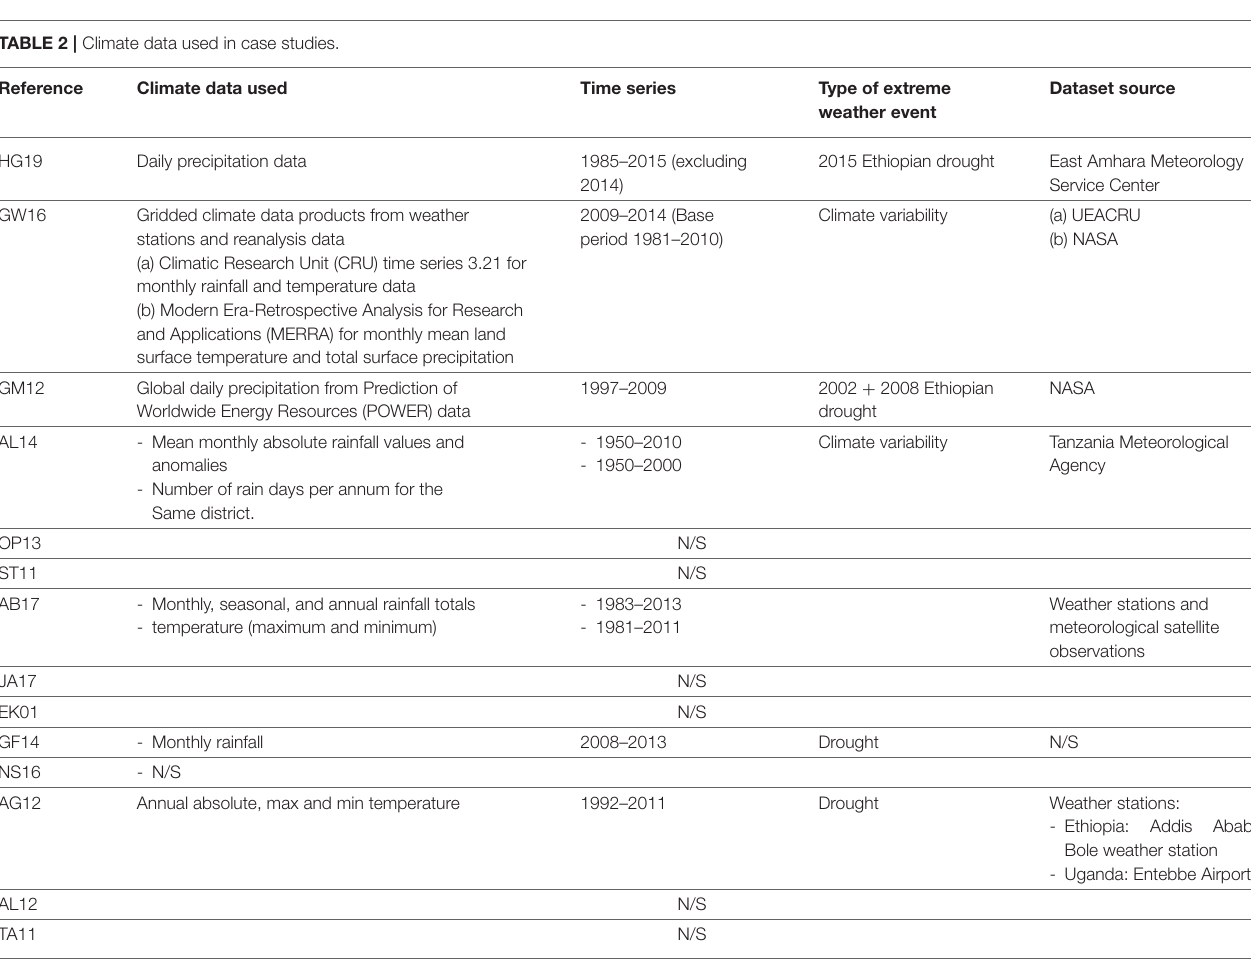
TABLE 2 | Climate data used in case